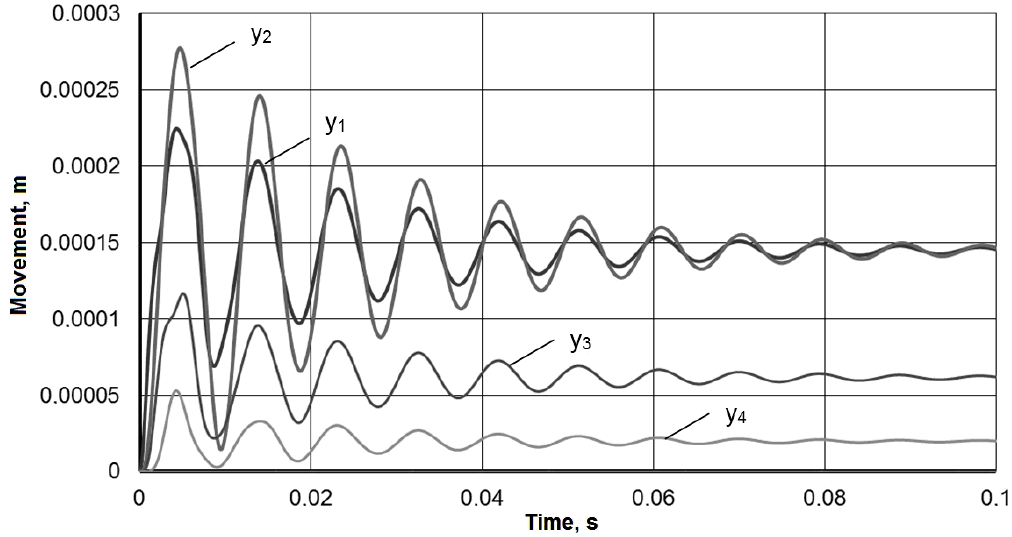
Figure 4. System numerical solution in Equation (1).